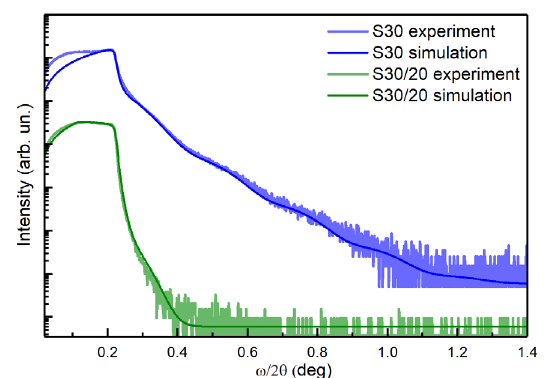
Figure 3. The XRR data obtained for sample S30 with the inclusion of a small number of self-aggregated AuNPs and for sample S30 / 20 . The experimental data were fitted with the X’Pert Reflectivity software package based on the Parratt formalism [45].